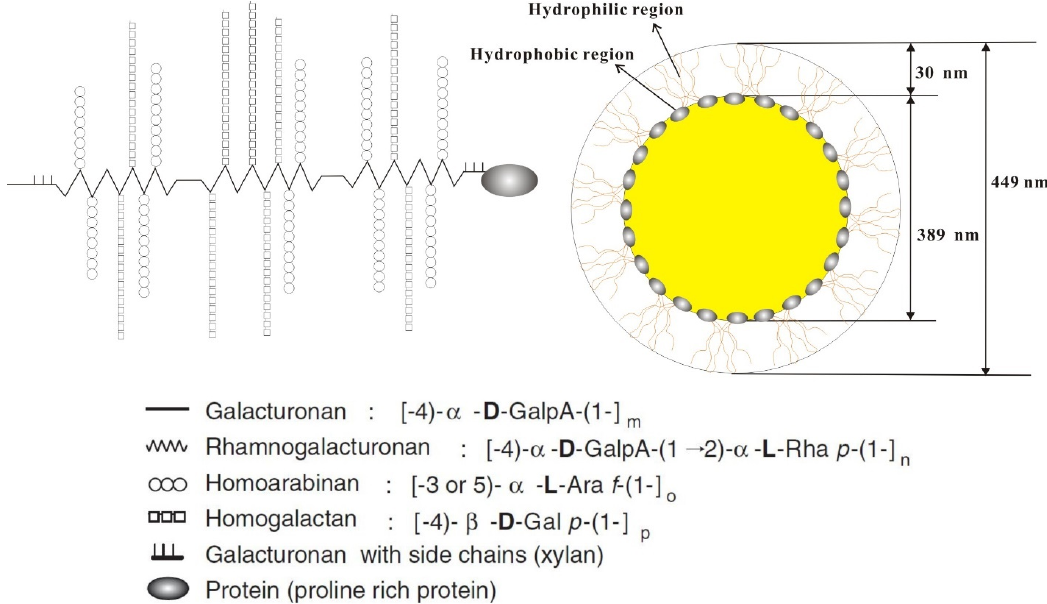
Figure 3. The chemical structure of soybean soluble polysaccharide (SPSS) ( left ) and a schematic diagram of SSPS-stabilized emulsion droplets ( right ).